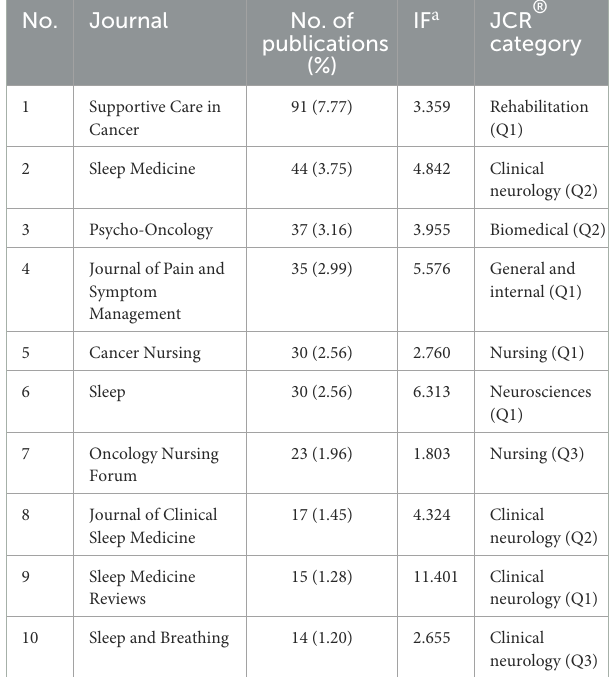
TABLE 1 Top 10 most prolific journals in cancer and sleep